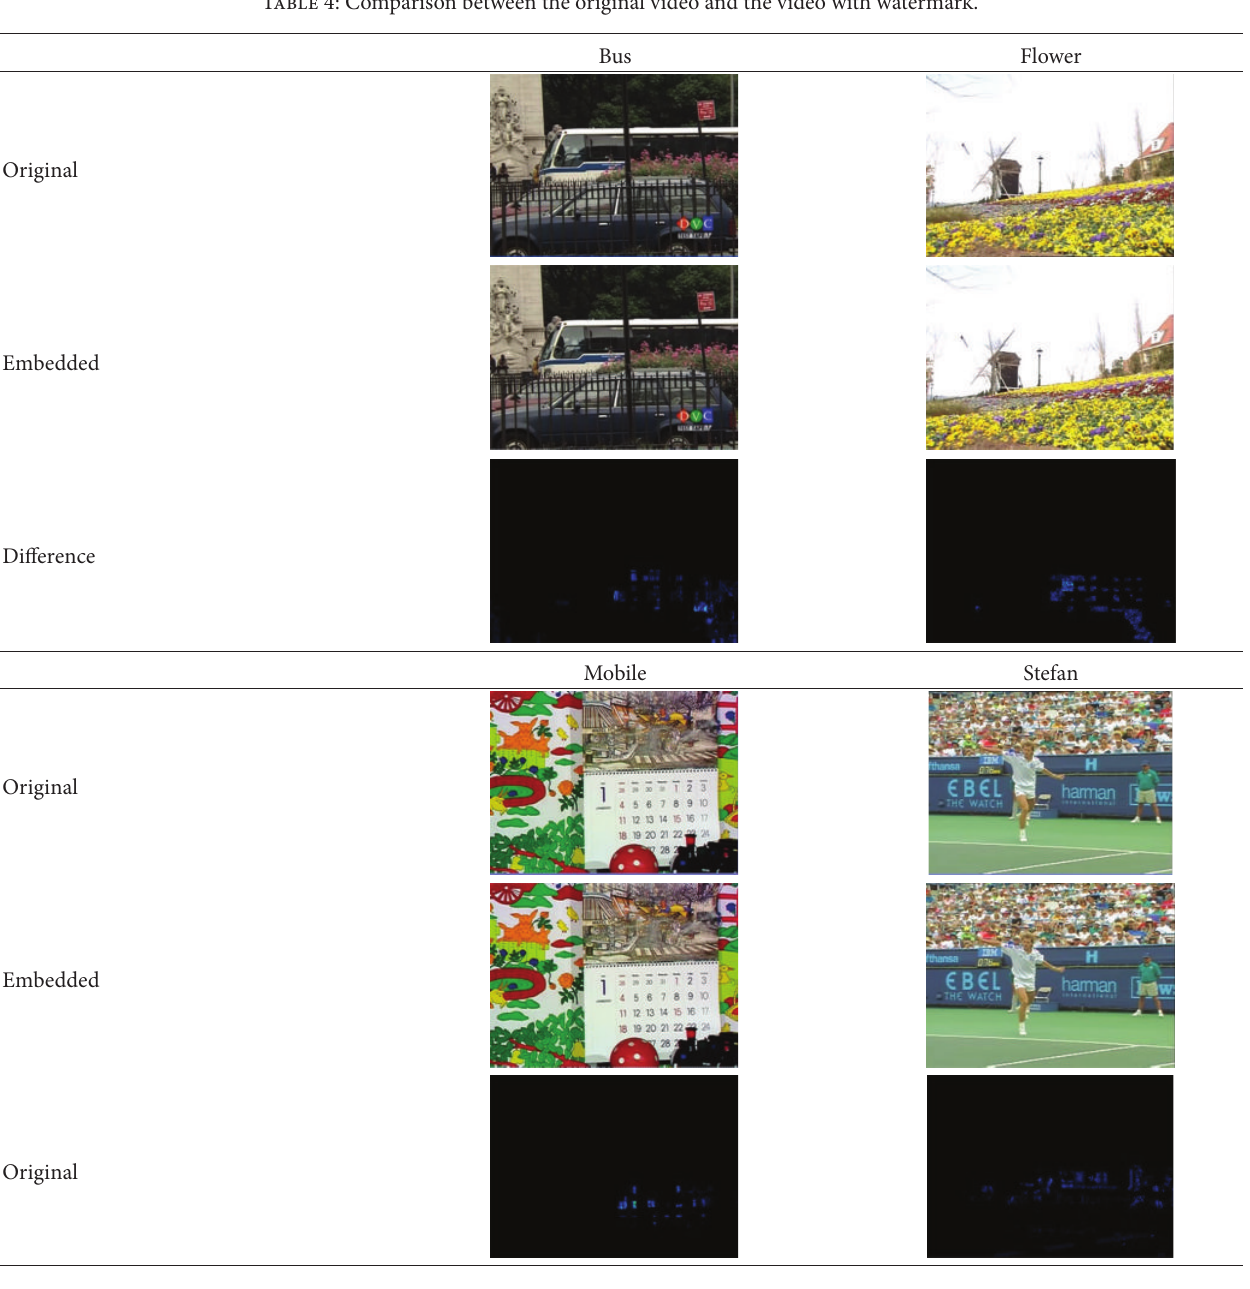
Table 4: Comparison between the original video and the video with